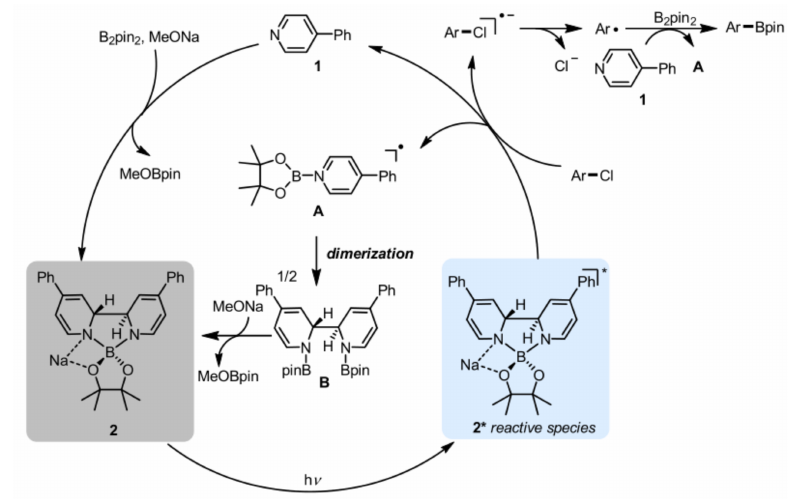
Figure 13. Borylation mechanism of aryl chloride. Reprinted with permission from Ref. [58]. Copy- right 2019, American Chemical Society.